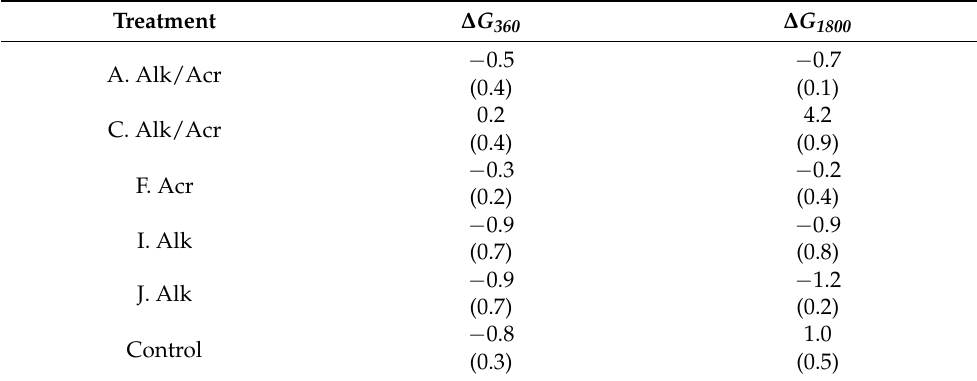
Table 5. Gloss change ( ∆ G ) of coated and uncoated CLT after 360 h and 1800 h of artificial weathering (Standard